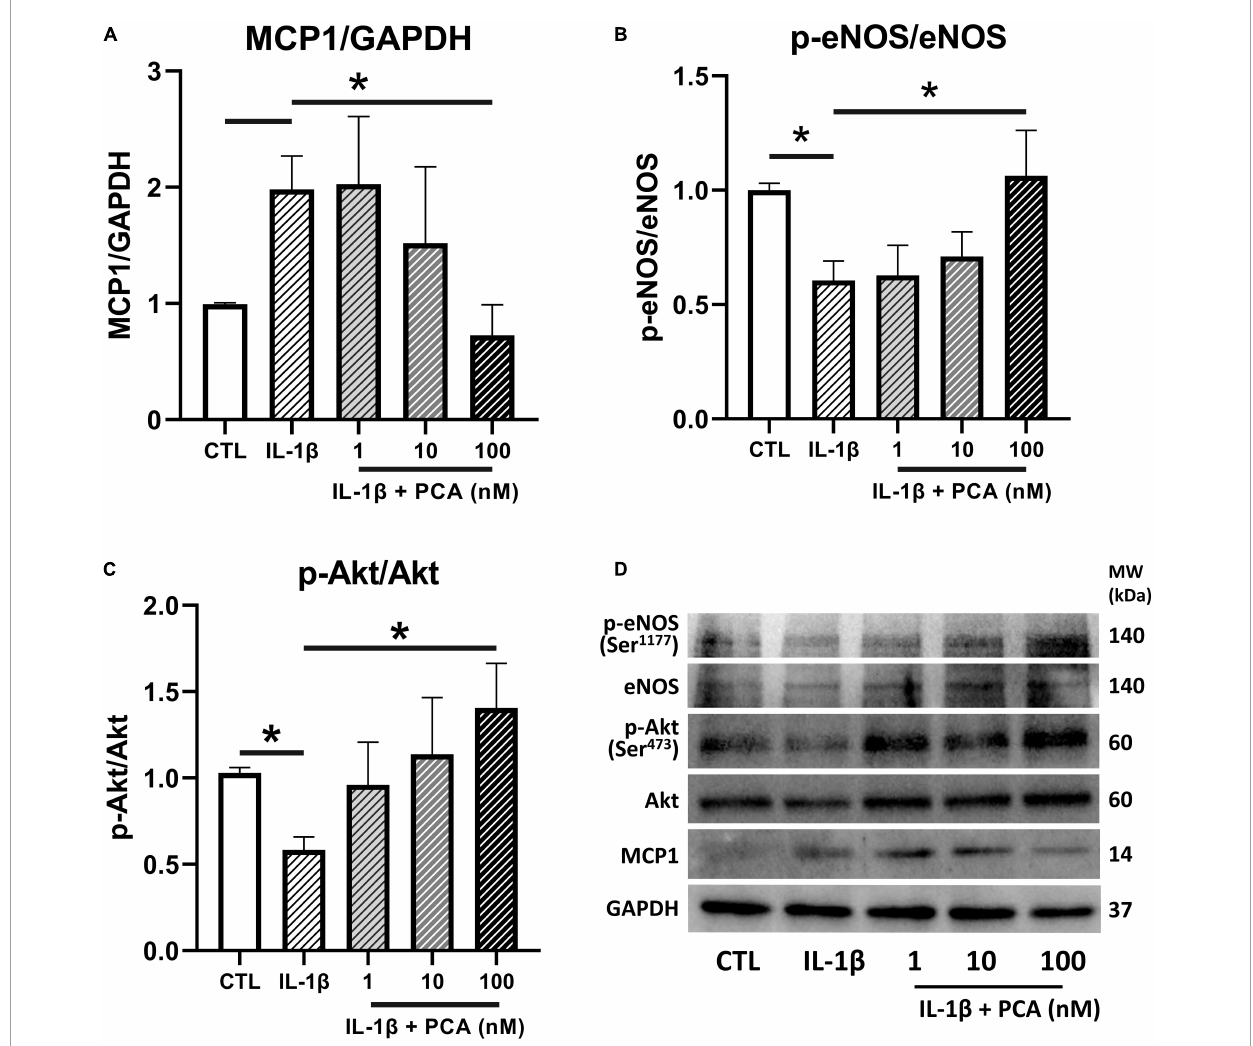
FIGURE4 PCA inhibited MCP1 but promoted p-eNOS/eNOS and p-Akt/Akt protein expressions in IL-1 β -treated endothelial cells. Summarized protein quantification of (A) MCP1, (B) p-eNOS/eNOS and (C) p-Akt/Akt relative to GAPDH with and without IL-1 β (0.5 ng/mL) and PCA (1-100 nM) incubation with representative immunoblots (D) ; n = 6-7. P-eNOS, eNOS, 140 kDa; p-Akt, Akt, 60 kDa; MCP1, 25 kDa; GAPDH, 37 kDa. Data are presented in means ± SEM; * p < 0.05. PCA, protocatechuic